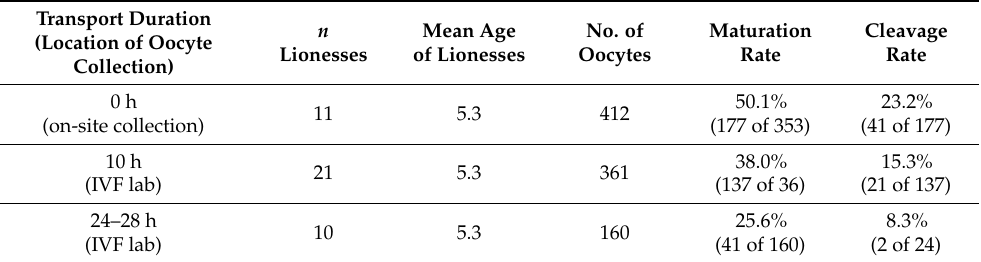
Table 5. Impact of time between retrieval of gonads and oocytes collection. For transportation, ovaries were stored in physiological salt solution in a Styrofoam box equipped with cool packs.